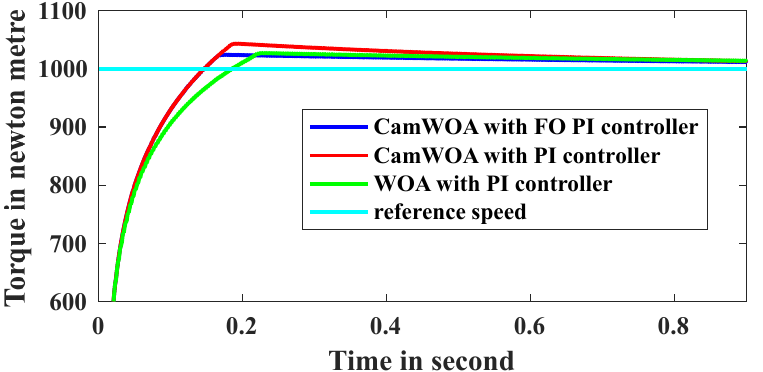
Figure 12. Zoom in of tracking of speed with reference speed by MWAO and WOA controller.